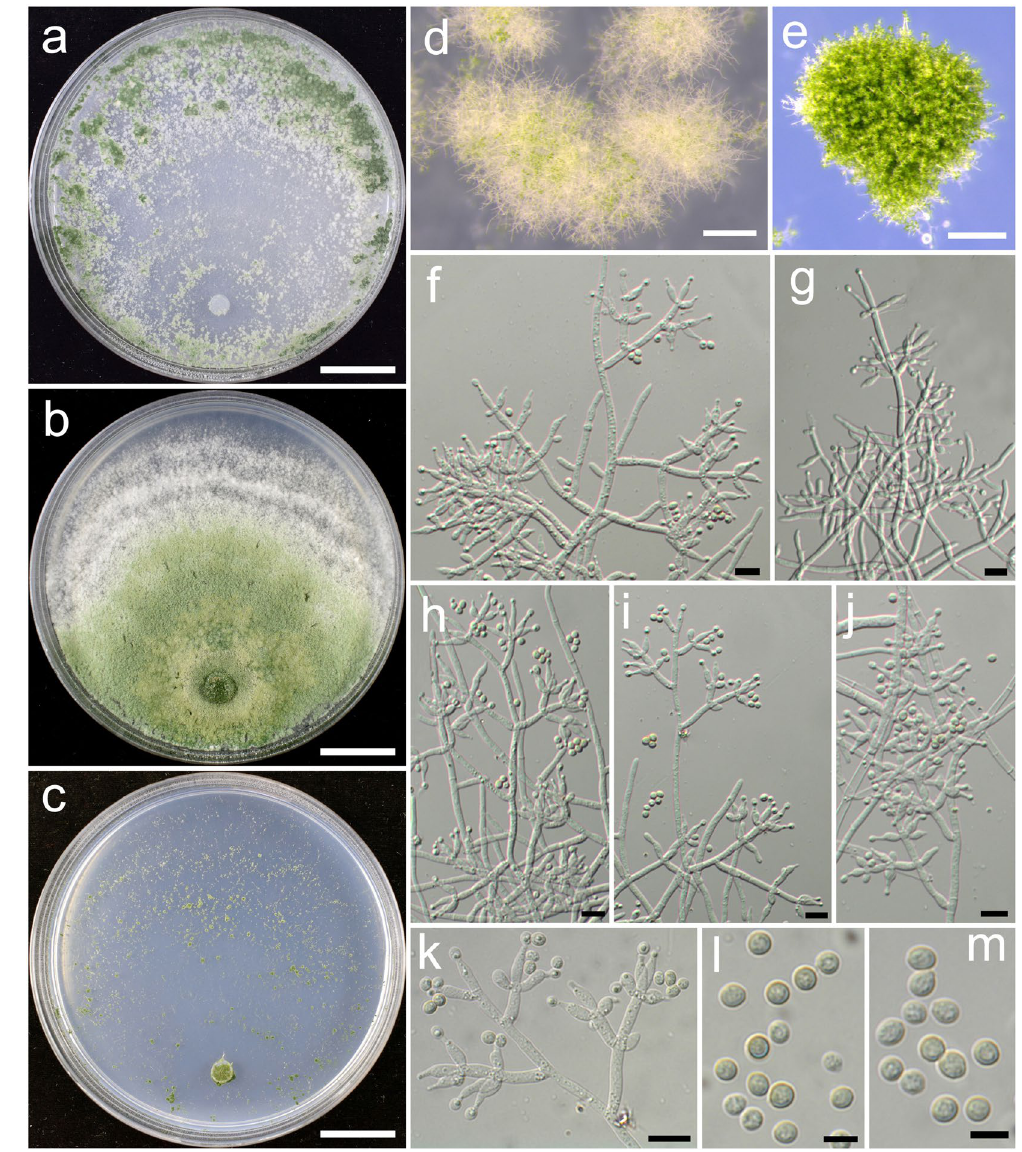
Figure 10. Trichoderma ganodermatis (HMAS 248856). ( a – c ) Cultures at 25 °C (a. on CMD, 10 d; b. on PDA, 7 d; c. on SNA, 10 d); ( d , e ) Conidial pustules (d. CMD, 7d; e. SNA, 7 d); ( f – k ) Conidiophores and phialides (PDA, 3 d); ( l , m ) Conidia (PDA, 3 d). Bars: a–c = 20 mm. d–e = 200 μ m. f–k = 10 μ m. l–m = 5 μ